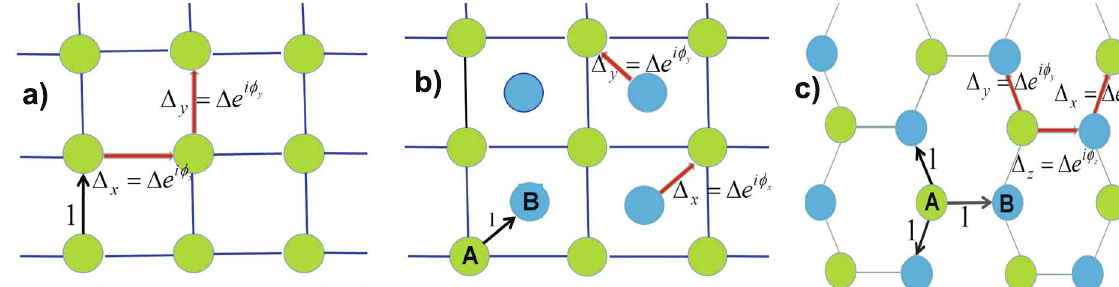
Figure 1. Square ( a ), centered square ( b ) and hexagonal ( c ) lattices and the parameters of the model (hopping integrals and superconducting order parameters). The types of links on the lattices: 1 denotes the magnitude of the nearest-neighbor hopping integral, Δ x , Δ y (in square) and Δ x , Δ y , Δ z (in hexagonal) lattices determine the pairing of spinless fermions located at the nearest-neighbor lattice sites along the links. The unit cells of the centered square and hexagonal lattices contain two atoms A and B. A strip geometry with edges is fixed along the x -direction for the square